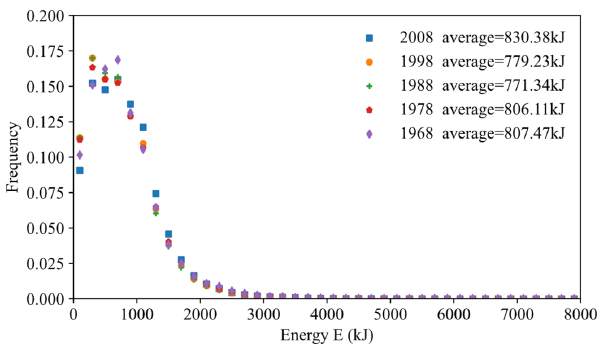
Figure 15. Distributions of daily energy expenditure (bin width = 200 kJ).